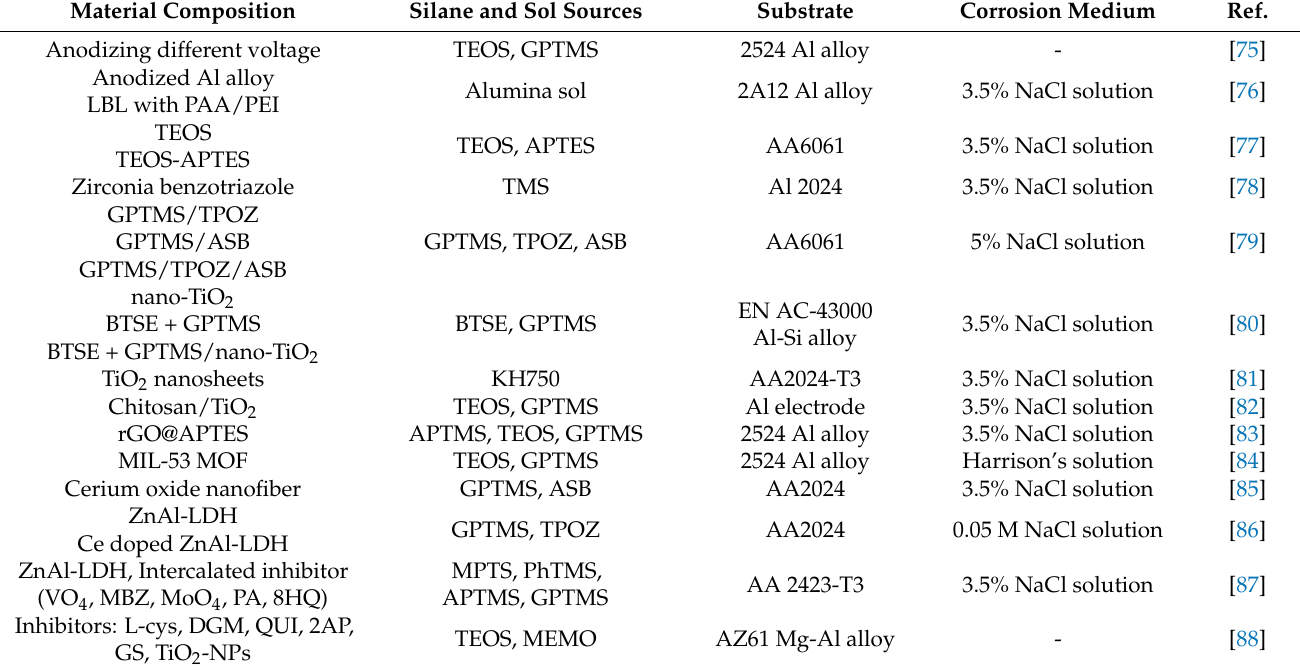
Table 2. Studies on corrosion resistance using hybrid sol-gel coating on aluminum